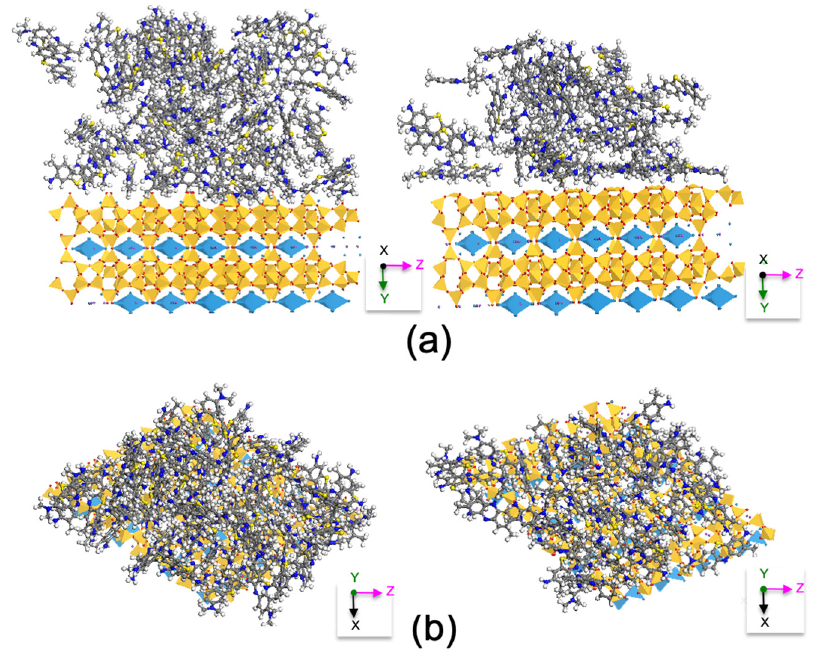
Figure 9. Molecular dynamic simulation showing TB uptake ( left ) and TB + SO ( right ) on the {010} surface projected along crystallographic a ( a ) and a ( b ) directions of ZEO.